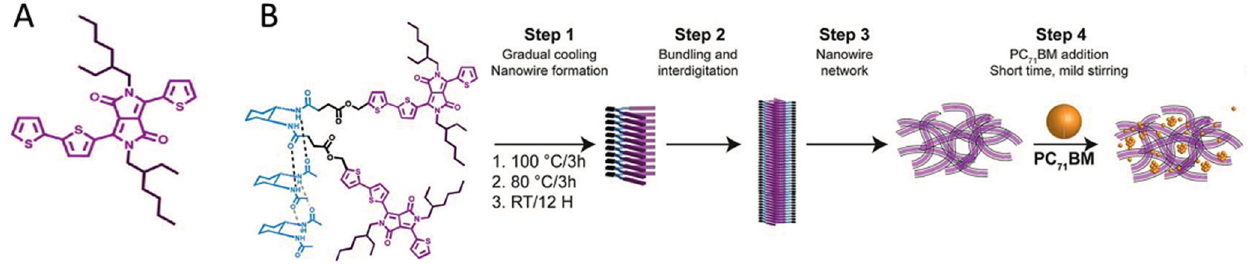
Figure 10. ( A ) Structure of diketopyrrolopyrrole (DPP); ( B ) Scheme for generating hydrogen-bonded diketopyrrolopyrrole (DPPHP) nanowires. Adapted from [132] with permission from The Royal Society of